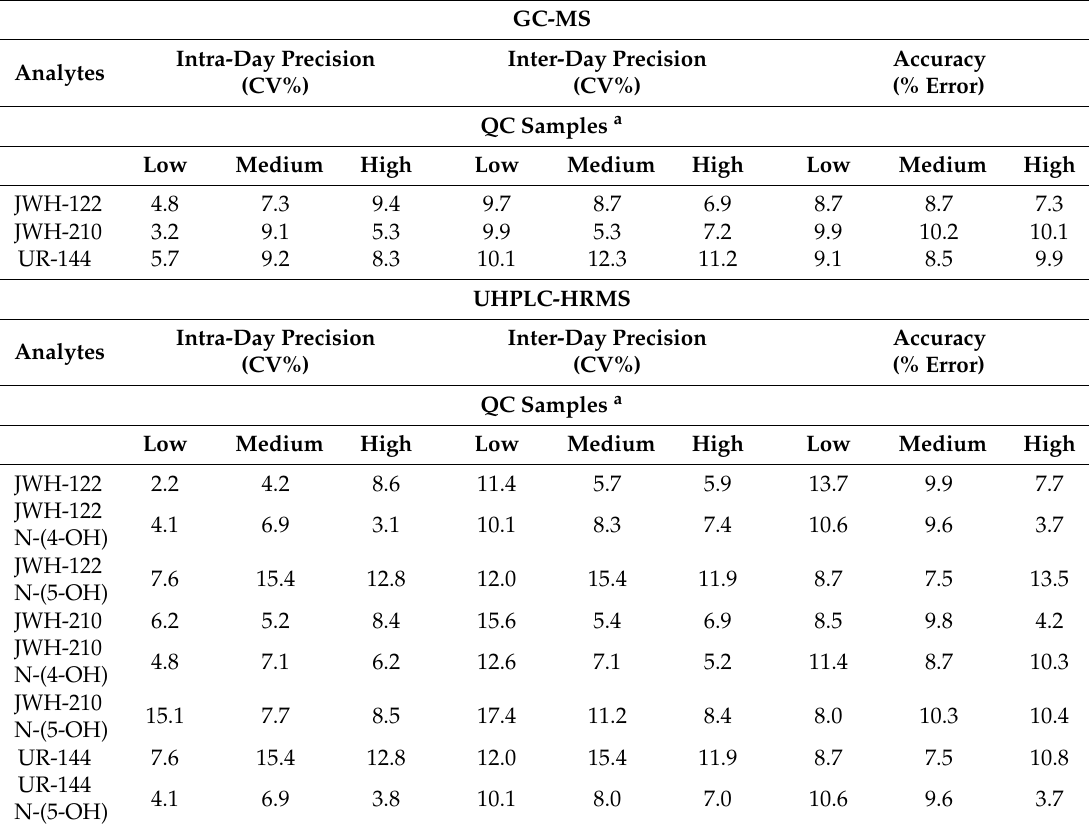
Table 2. Intra- and inter-day precision and accuracy values for SCs and their metabolites in OF by GC-MS and